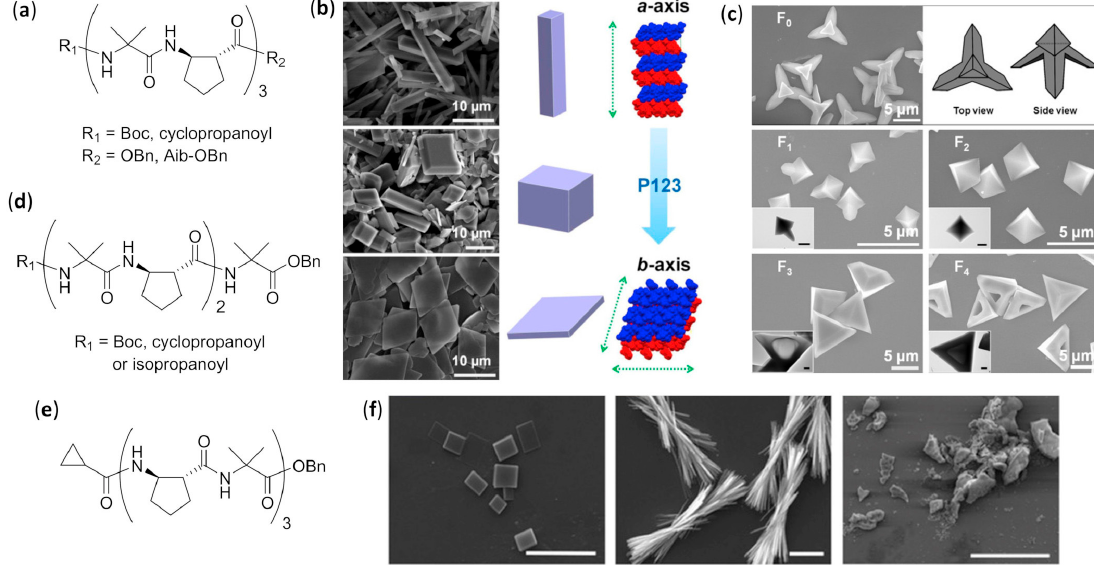
Figure 24. ( a ) General structure of alternating Aib-ACPC hexamers and heptamers (Refs. [261–265]); ( b ) SEM images of foldectures created from Boc-(Aib-ACPC) 3 -OBn added to P123 aqueous solutions at (top) 0.0 g L − 1 , (middle) 0.015 g L − 1 , and (bottom) 8 g L − 1 , and plausible mechanism for the formation